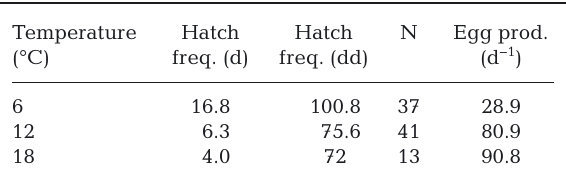
Fig. 5. Mean number of molts (MnM) against the relative age (RA) of male (blue) and female (red) Lepeophtheirus salmonis . Males develop faster than females and reach the adult stage (RA = 100% and MnM = 5.0) when the female RA is about 80%. To il- lustrate this, the RA is given in separate x -axes for males and females. The graph shows the develop- ment pattern and indicates when the male and fe- male populations are in phases of instar growth (sta- ble MnM) and the phases when the populations are molting (increasing MnM). At MnM = 1.0, the ma- jority of the population is ch1, and at MnM = 1.5, 50% of the population has become ch2. The begin- ning and end of the population molt phases were identified from Fig.